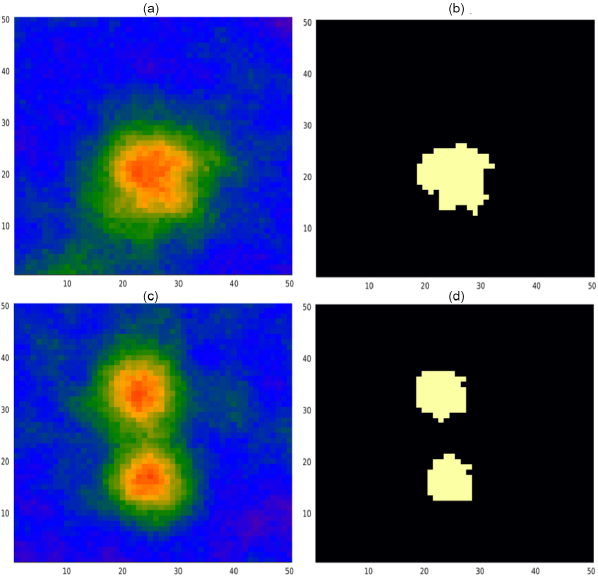
Figure 11. (a, b) Single-body, variable-location realization. Panel (a) shows the mineral field generated by a primary process with a randomly selected centroid location. Panel (b) is the correspond- ing massive ore map. (c, d) Two-body realization. Panel (c) shows the mineral field generated by two primary processes, each with a randomly selected centroid location. Panel (d) is the corresponding massive ore